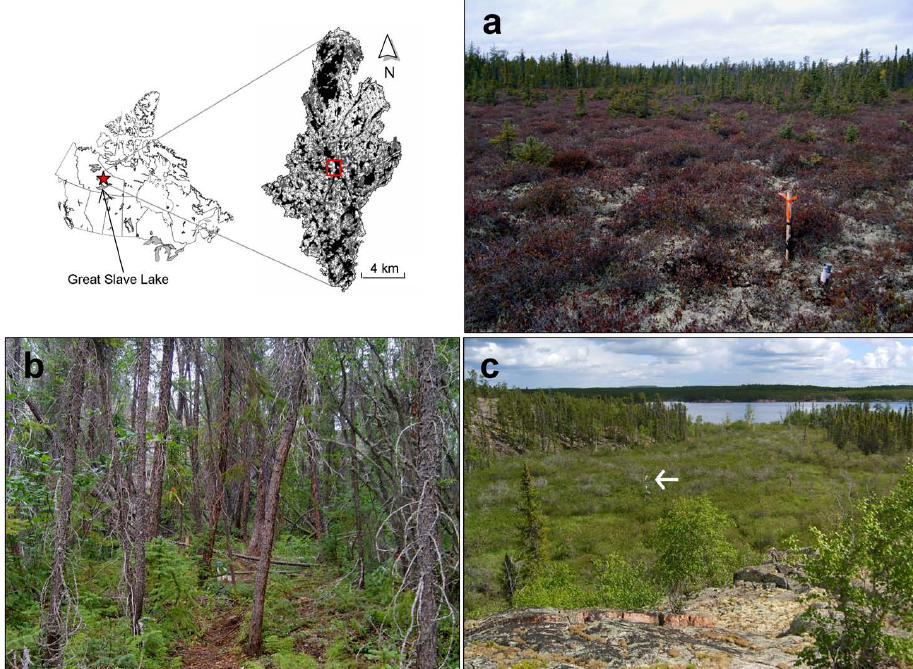
Fig. 1. The ∼ 165km 2 Baker Creek Basin, Northwest Territories, Canada (top left) with the solid black indicating location of lakes. The selected study sites: (a) peatland site, with a piezometer nest in foreground, (b) valley site, facing upslope, north-northeast, and (c) wetland site with Vital Lake in background. Arrow shows location of wetland climate